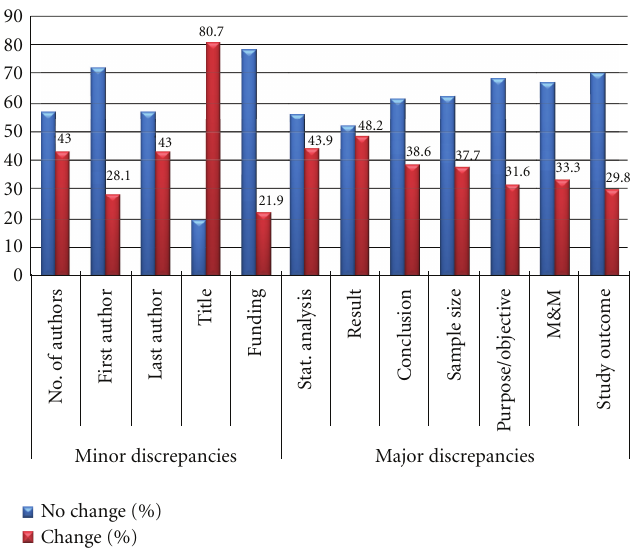
Figure 2: Comparison between minor and major